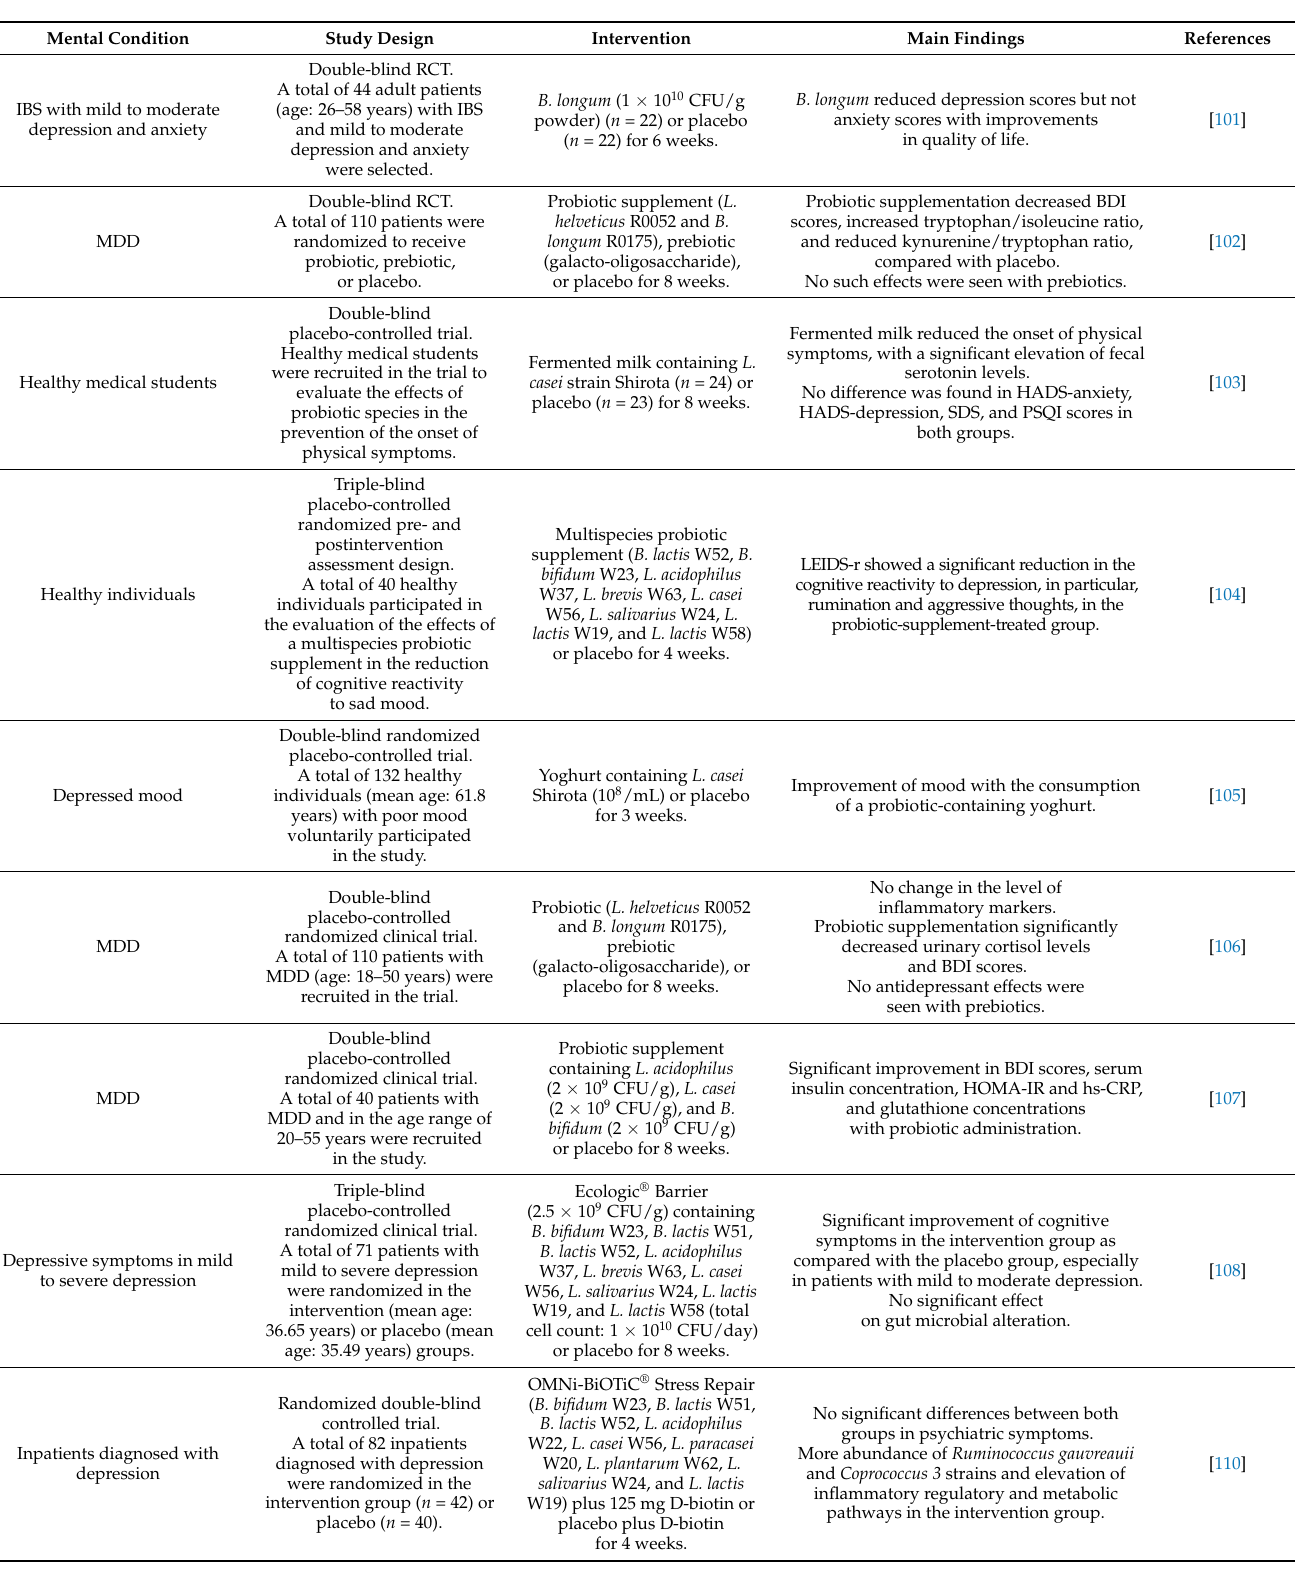
Table 2. Antidepressant efficacy of probiotic